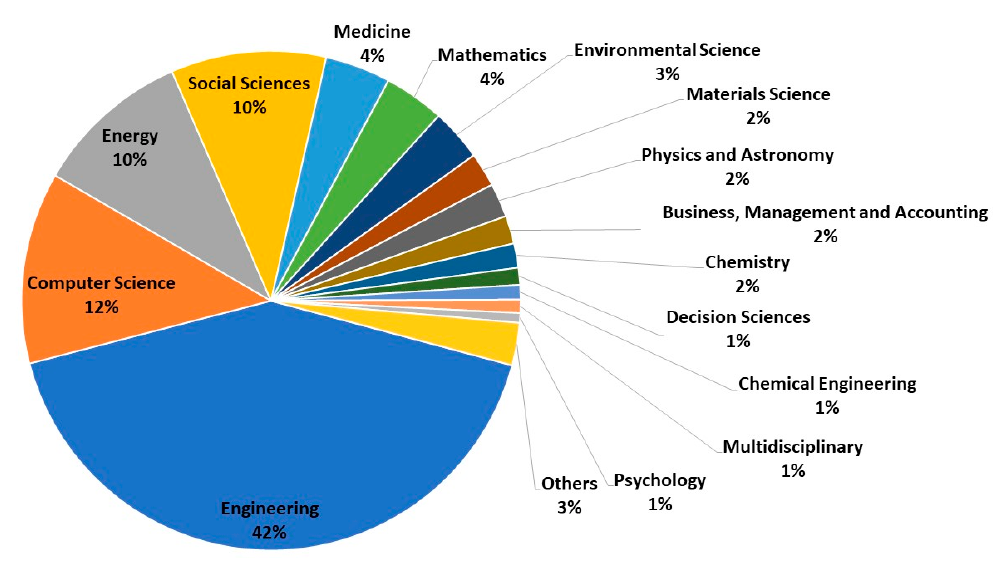
Figure 4. Distribution by thematic category of scientific production in relation to electric bicycles.